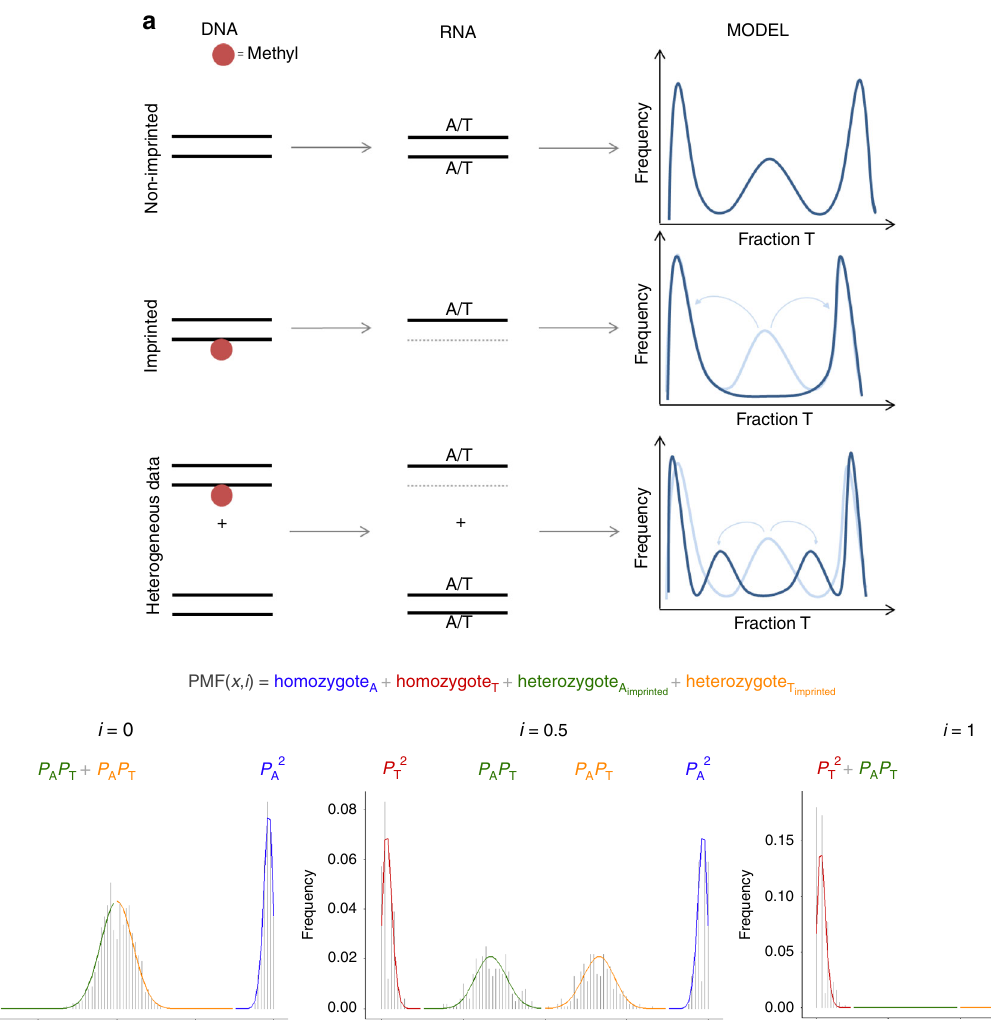
here taken into account. Subsequently, maximum likelihood estimation was used to estimate the degree of imprinting (i) and a likelihood ratio test was constructed to detect signi fi cant imprinting. A detailed discussion of the different elements of this PMF and the analytical framework can be found in the following subsections. All analyses were performed in R (v3.3.2) 57 , scripts are available upon reasonable request.